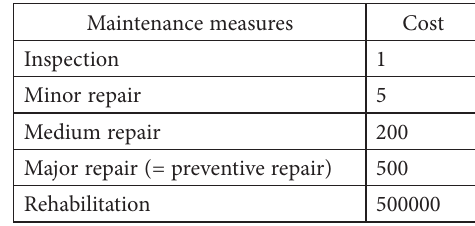
Table 6. Assumptions of the costs of different maintenance